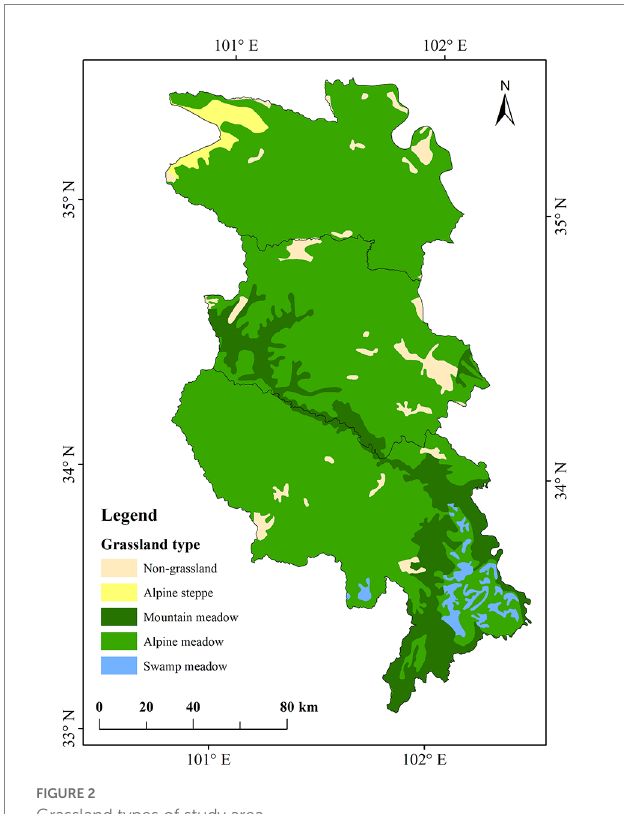
FIGURE 2 Grassland types of study